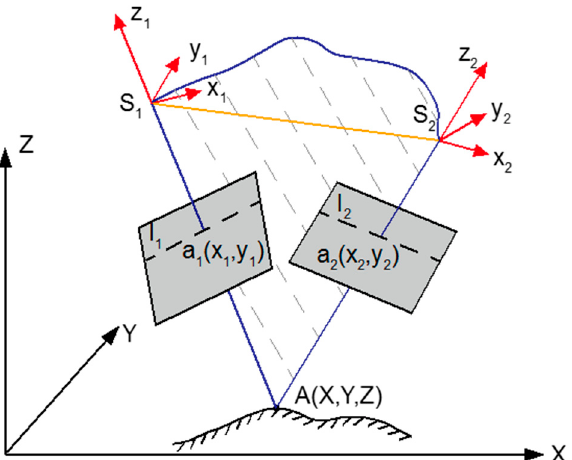
Figure 2. Digital elevation model (DEM) generation from stereo images, modified from [51]. a 1 and a 2 are the image points corresponding to the object point (A) on the true ground, S 1 and S 2 are the projection center, respectively. S 1 S 2 is the photographic baseline, and the shadow lines are shown as the epipolar plane between the photographic baseline and the object point. The intersection line (e.g., l 1 and l 2 ) between the epipolar plane and the image plane is the epipolar line.